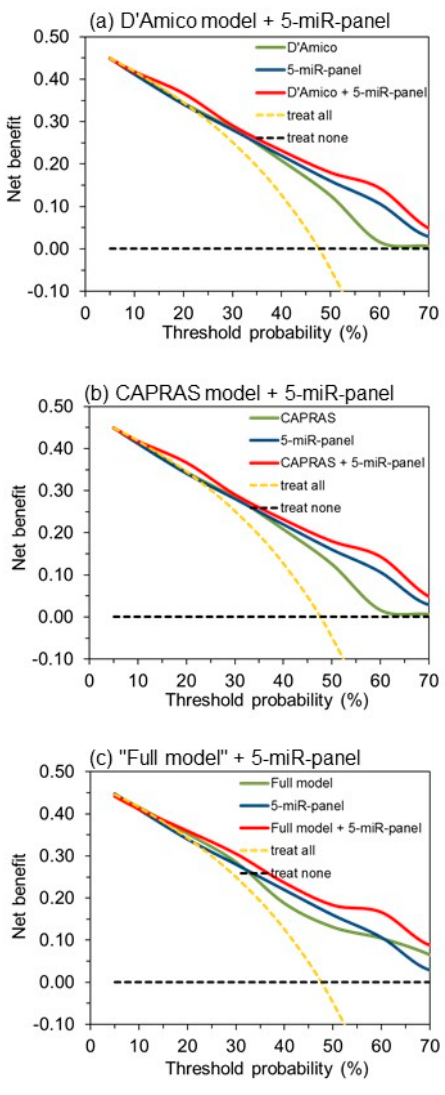
Figure 4. Decision curve analysis to demonstrate the benefit of the inclusion of the five-miR-panel into only clinicopathological variables-based biochemical recurrence predictive tools, according to ( a ) D’Amico et al. [15], ( b ) Cancer of the Prostate Risk Assessment Postsurgical Score (CAPRAS) [16], and ( c ) the "full model" used in this study (Table 6).